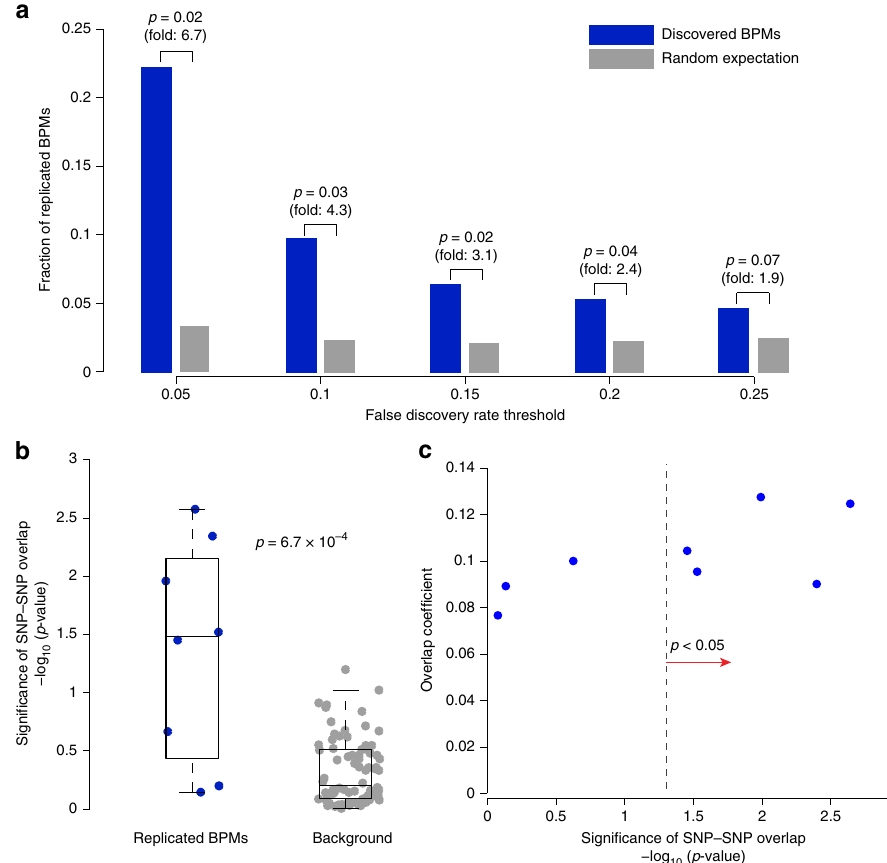
Fig. 4 Replication analysis of BPM interactions discovered from PD-NIA in an independent cohort (PD-NGRC). a Each BPM interaction discovered from the PD-NIA data was tested for replication in the PD-NGRC cohort. The collective signi fi cance of replication of the entire set of interactions discovered in PD- NIA was evaluated by measuring the fraction of signi fi cant BPMs discovered from PD-NIA that replicated in the PD-NGRC cohort (blue bars) at fi ve different FDR cutoffs ( x -axis). The random expectation for the number of replicating BPMs is plotted for comparison and was estimated based on 10 random sample permutations (gray bars). b Sample permutation-based approach to check whether the individual SNP – SNP interactions supporting the replicated pathway-level interactions are similar between PD-NIA and PD-NGRC. The signi fi cance of the overlap (blue dots) of SNP – SNP interactions in each of the BPMs replicated in PD-NGRC was assessed by a hypergeometric test. The random expectation for the level of overlap was estimated by measuring the SNP – SNP interaction overlap in the same set of BPMs in 10 random sample permutations of the PD-NGRC cohort (gray dots). The SNP-SNP interaction overlap is modest but signi fi cantly higher than random expectation (one-tailed rank-sum test p = 6.7 × 10 − 4 ). c Scatter plot of the signi fi cance of SNP – SNP interaction overlap in each of the replicated BPMs ( − log 10 hypergeometric p -value) versus a direct measure of overlap (overlap coef fi